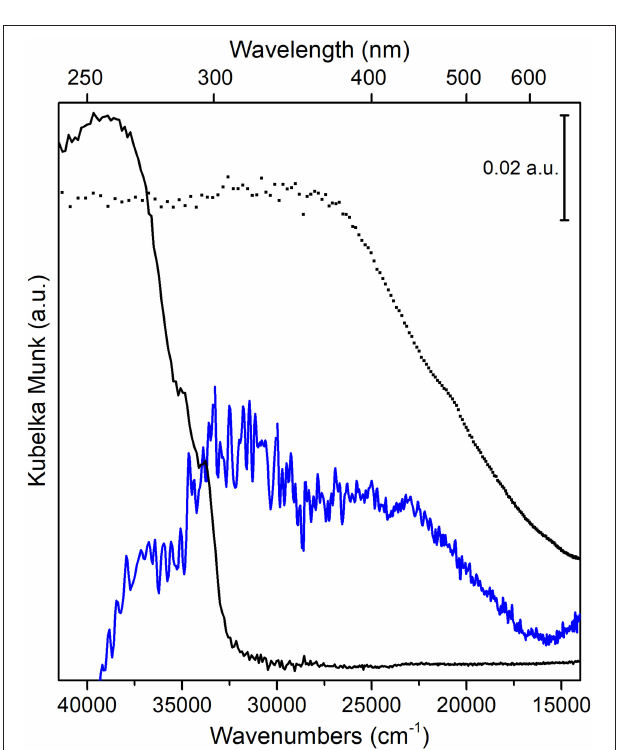
FIGURE 9 | UV-vis spectra of: PS-co-DVB pyrolyzed at 800 ◦ C (black curve); carbonized ZnCl 2 /PS-co-DVB spheres after impregnation with Fe (III) salt and treatment at 800 ◦ C (blue curve); Fe 3 O 4 , used as a reference (black dotted